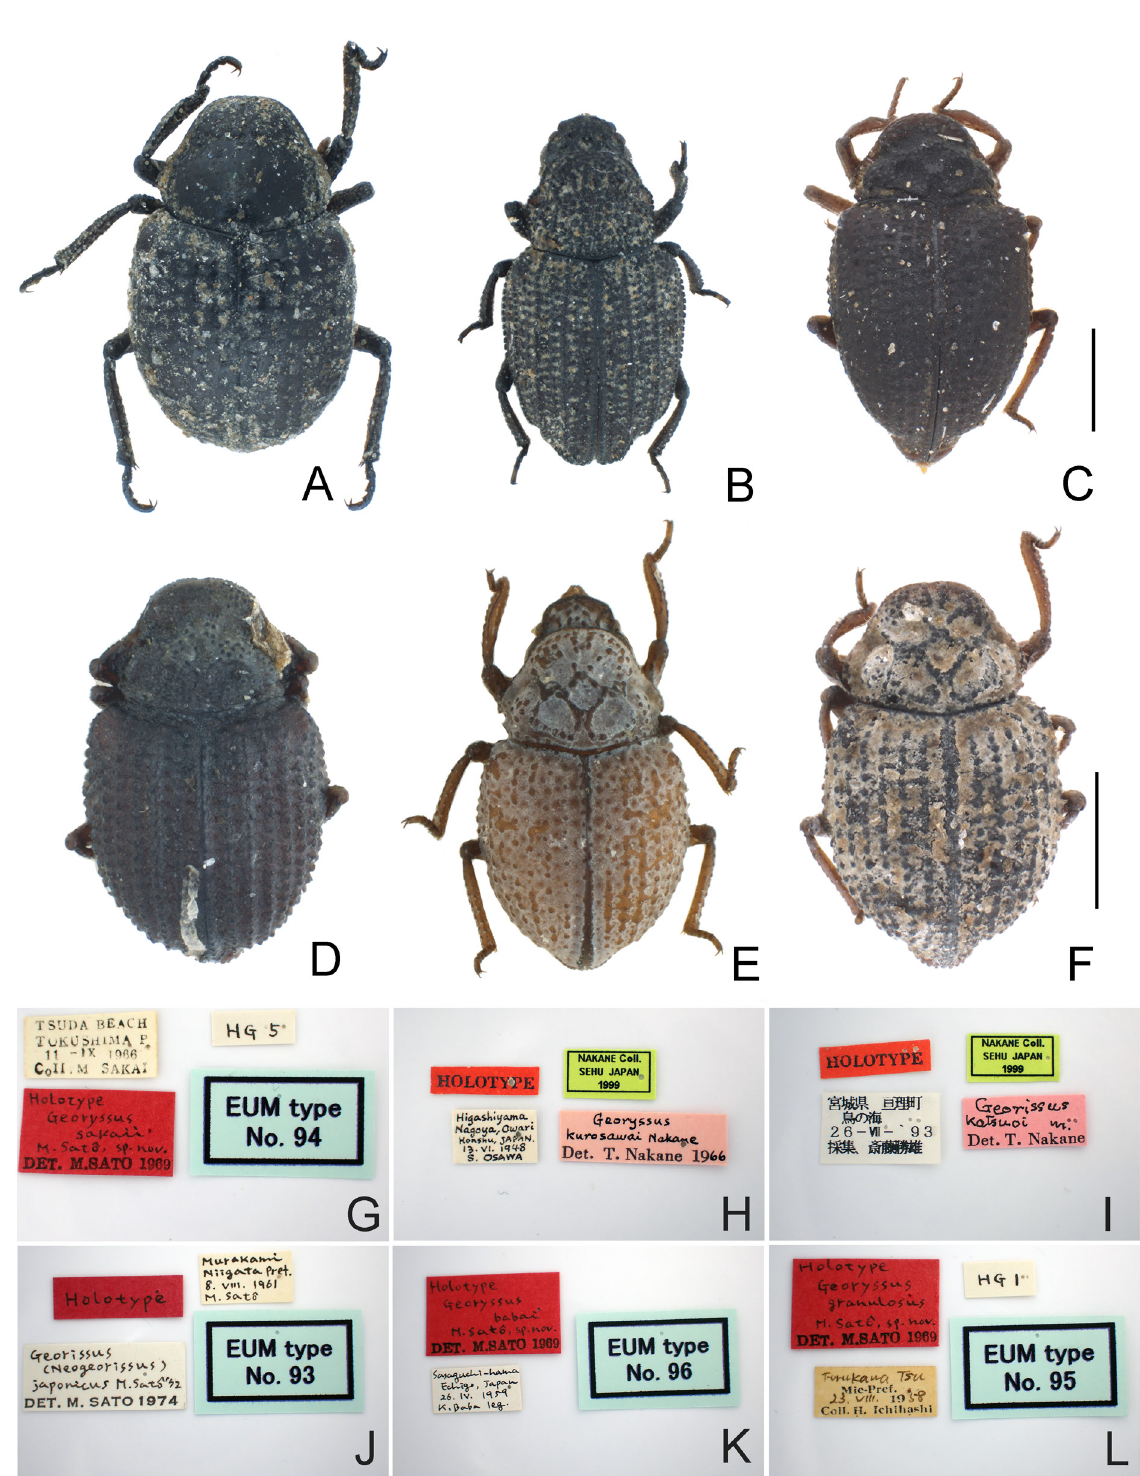
Fig. 3. Holotypes of Georissus spp. A–F . Dorsal habitus. G–L . Labels. A, K . G . ( G .) babai Satô, 1970, ♂ (EUMJ). B, L . G . ( Ni .) granulosus Satô, 1972, ♀ (EUMJ). C, H . G . ( Ne .) kurosawai Nakane, 1963, ♂ (SEHU). D, J . G . ( Ne .) japonicus Satô, 1972, ♂ (EUMJ). E, G . G . ( Ne .) sakaii Satô, 1972, ♂ (EUMJ). F, I . G . ( Ne .) katsuoi Nakane, 1995 (SEHU). Scale bars = 0.5